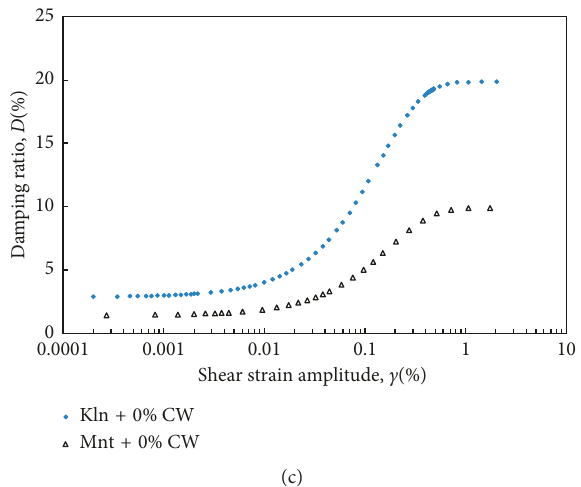
020406080100120